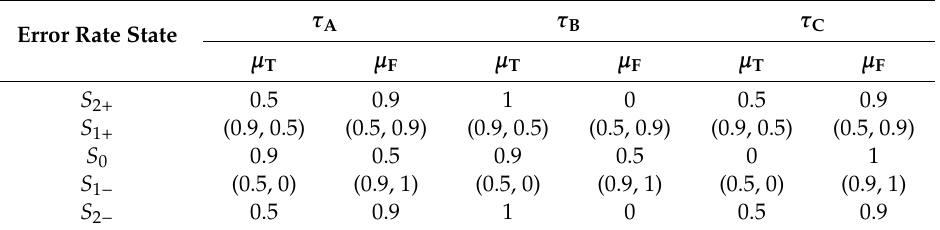
Table 3. Relationships among active factors and motor variables.